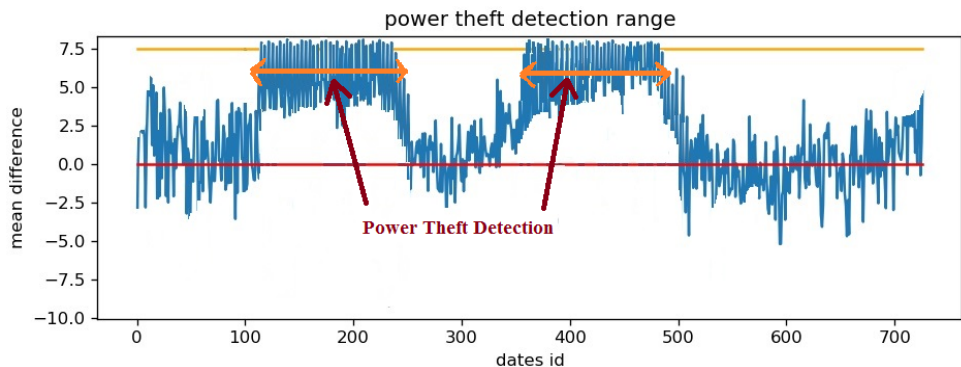
Figure 14. The case of power theft detection.